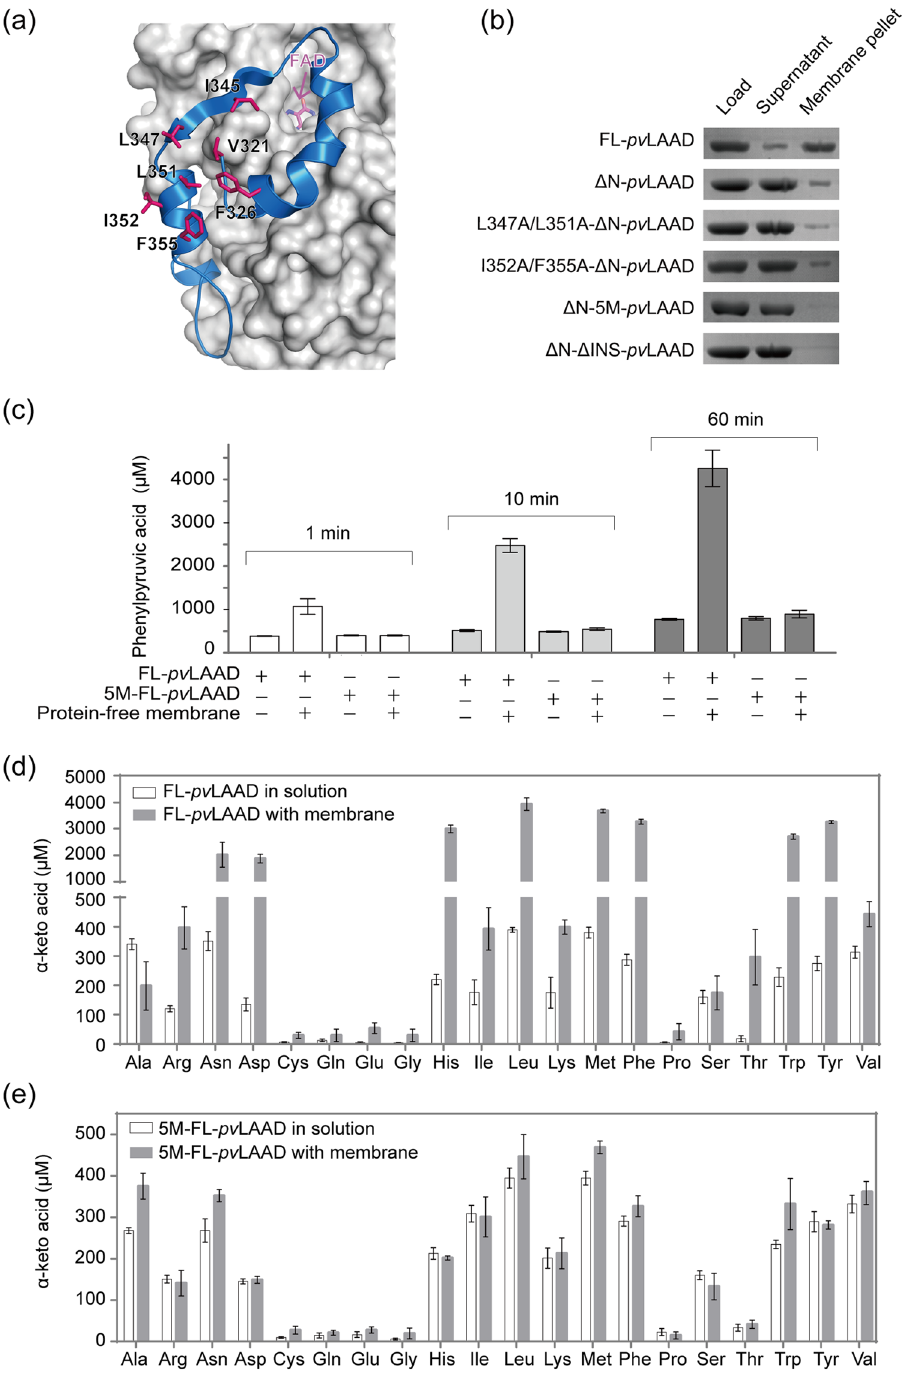
Figure 2. The INS-membrane interactions enhance the enzymatic activities and modulate the substrate preference of pv LAAD. ( a ) The cartoon drawing of the INS (blue) of pv LAAD. Seven of the conserved surface-exposed hydrophobic residues are drawn as sticks (magenta). ( b ) Membrane binding of INS-mutated pv LAADs were detected by membrane co-pelleting assays. pv LAADs co-pelleting with membrane or staying in supernatant were analyzed with SDS-PAGE. FL- pv LAAD was used as the positive control, and the double- truncated Δ N- Δ INS- pv LAAD was used as the negative control. Although the N-terminal Tat peptide is the major membrane-binding site of pv LAAD, a small fraction of Δ N- pv LAAD still co-pelleted with the liposome through the INS-mediated membrane binding. Two double-mutated Δ N- pv LAAD proteins showed the similar membrane-binding capability to the wild-type Δ N- pv LAAD. But, co-pelleting of the quintuple- mutant Δ N- pv LAAD (5M- Δ N- pv LAAD) could not be observed, and all of the 5M- Δ N- pv LAAD protein stayed in the supernatant, indicating that the quintuple mutation completely abolished the membrane-binding capability of the INS. ( c ) Catalytic activities of FL- pv LAAD and 5M-FL- pv LAAD with or without membrane presence were tested at three different time points (1, 10 and 60 min). FL- pv LAAD and 5M-FL- pv LAAD